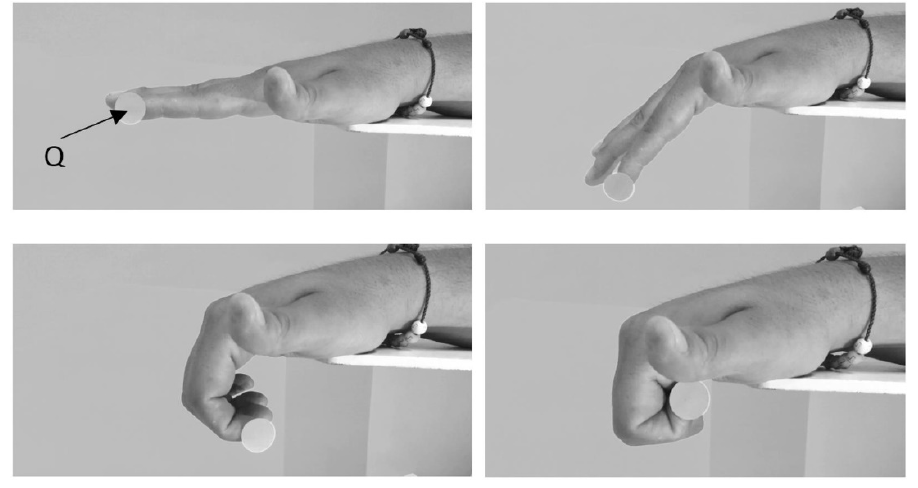
Figure 2. Decomposition of the video in images.